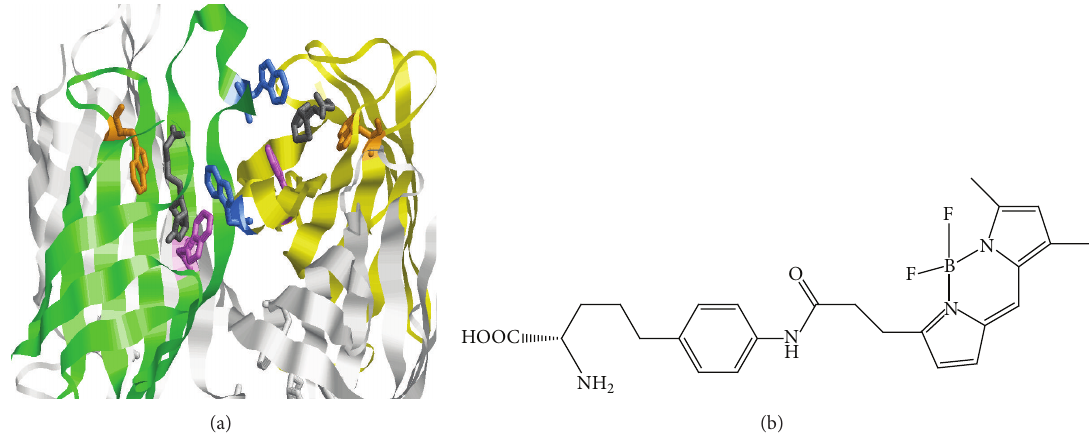
Figure 1: (a) The homo tetrameric constitution of a natural streptavidin (PDB ID: 1SWE). Subunit A was colored green, subunit B was colored yellow; to be easy to see, both subunits C and D were colored white. Biotin was colored with gray. On the other hand, Trp79, Trp108, and Trp120 in subunits A and B were colored orange, violet, and blue, respectively. Obviously the Trp120 was close to the Trp79 and the Trp108 of the neighbor subunit. (The distance from Trp120 to Trp79 of the neighbor subunit is 8.74 ˚ A and Trp120 to Trp108 of the neighbor subunit is 6.78 ˚A.) (b) The chemical structure of the